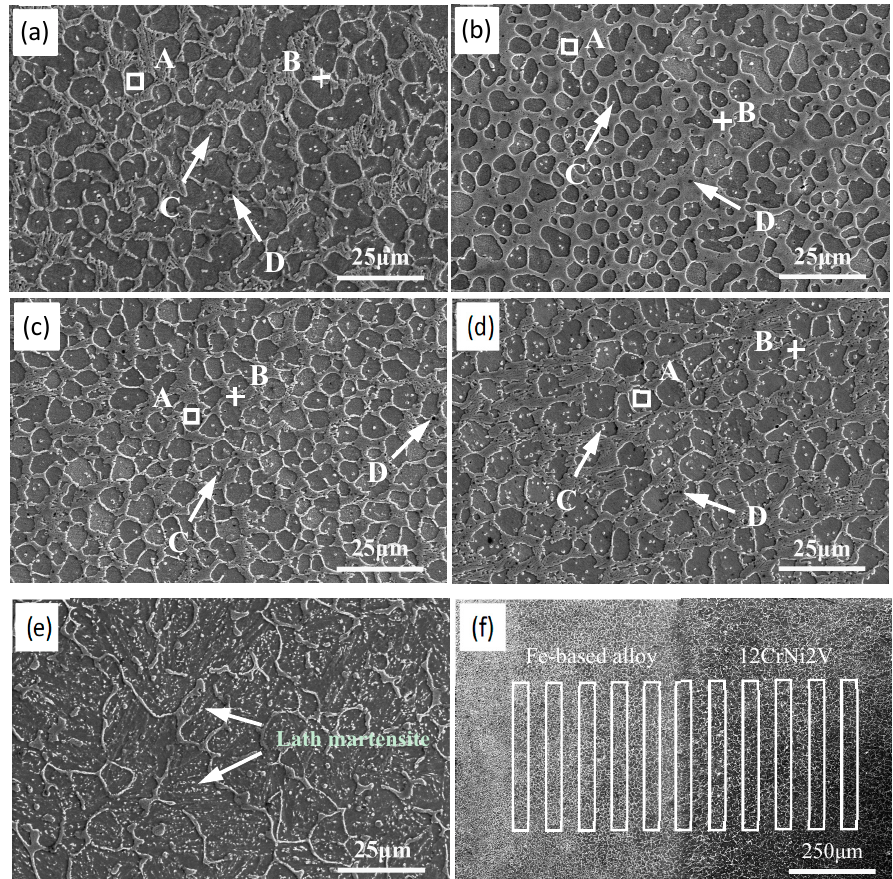
Figure 5. SEM images of the microstructures and interface of the laser melting deposited Fe-based alloy gradient materials ( a ) S1; ( b ) S2; ( c ) S3; ( d ) S4; ( e ) 12CrNi2V; ( f ) interface.